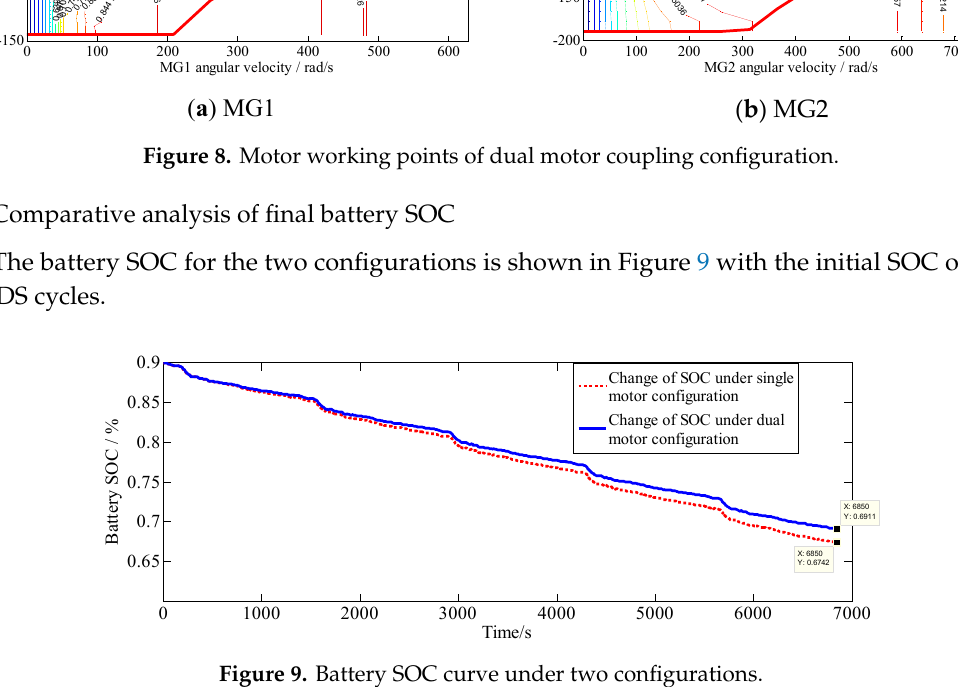
Figure 8. Motor working points of dual motor coupling configuration.